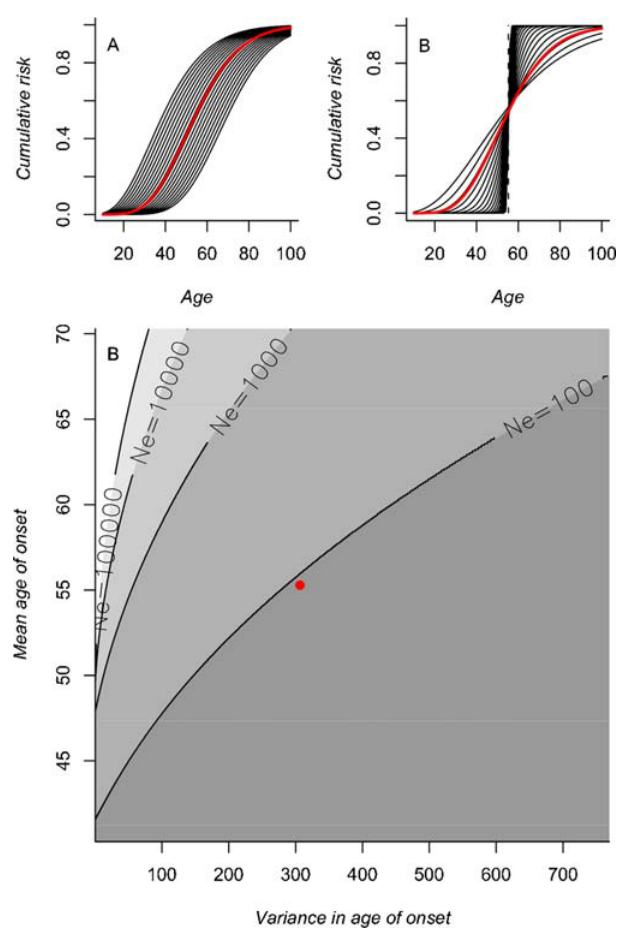
Figure 3. Selection on late-onset diseases. To explore a range of patterns of age of onset, we altered the observed cumulative risk with age F bo ( x ) of developing either breast or ovarian cancer for females carrying a BRCA1 susceptibility allele estimated from [9] (red line) by changing the mean from age 40 to 70 (A) and the variance from 100 to 800 (B). This was achieved by altering parameters a and b of the cumulative gamma. We calculated the minimum effective population size Ne min =10/2s necessary for negative selection to dominate over drift [18] corresponding to BRCA1 -alleles associated with each of these curves. These Ne min are shown in (C) for the Quebec population. The point represents values estimated from [9] for the cumulative risk of developing breast and ovarian cancer given a mutation in BRCA1 (mean=55; variance=306; Ne min =92).